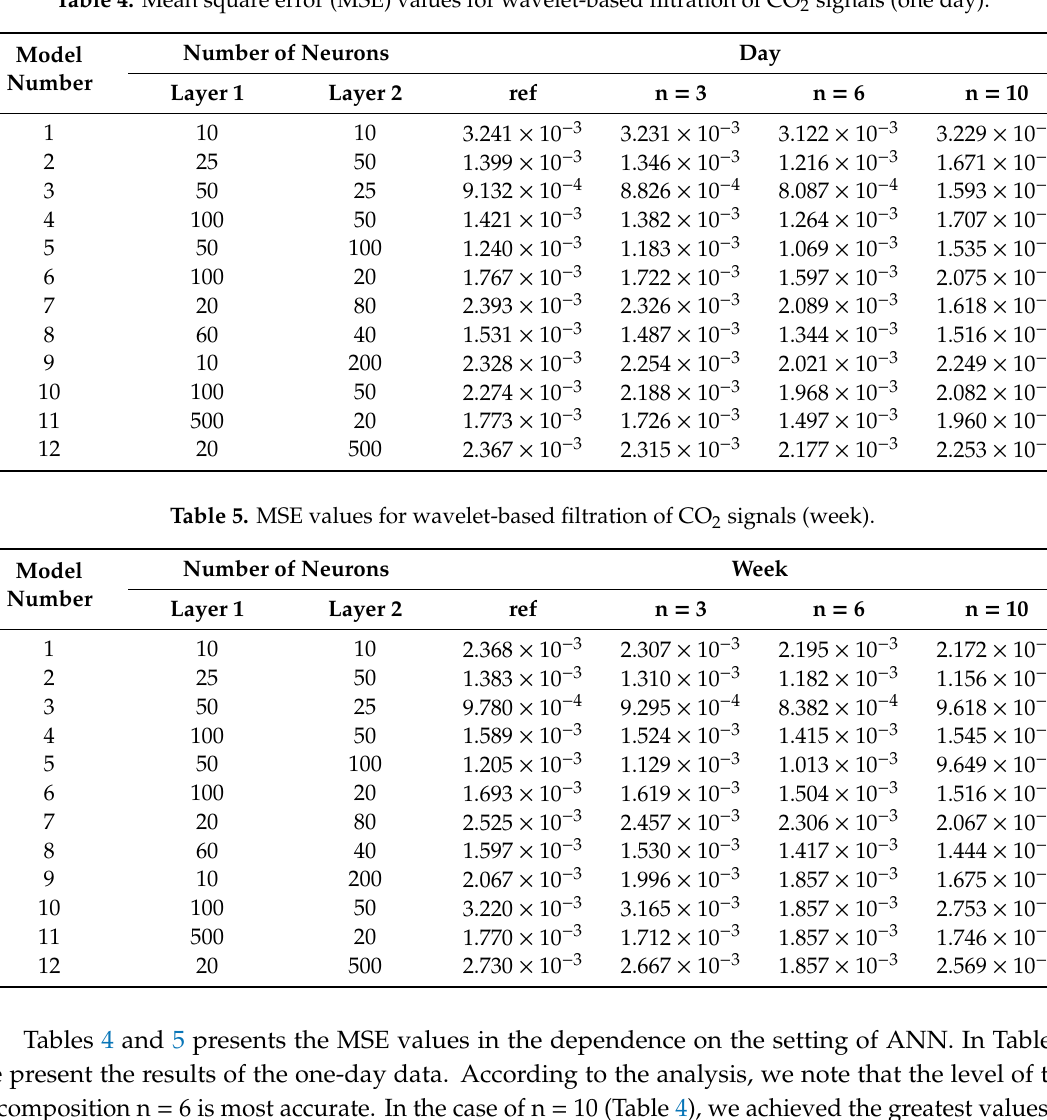
Table 4. Mean square error (MSE) values for wavelet-based filtration of CO 2 signals (one day).